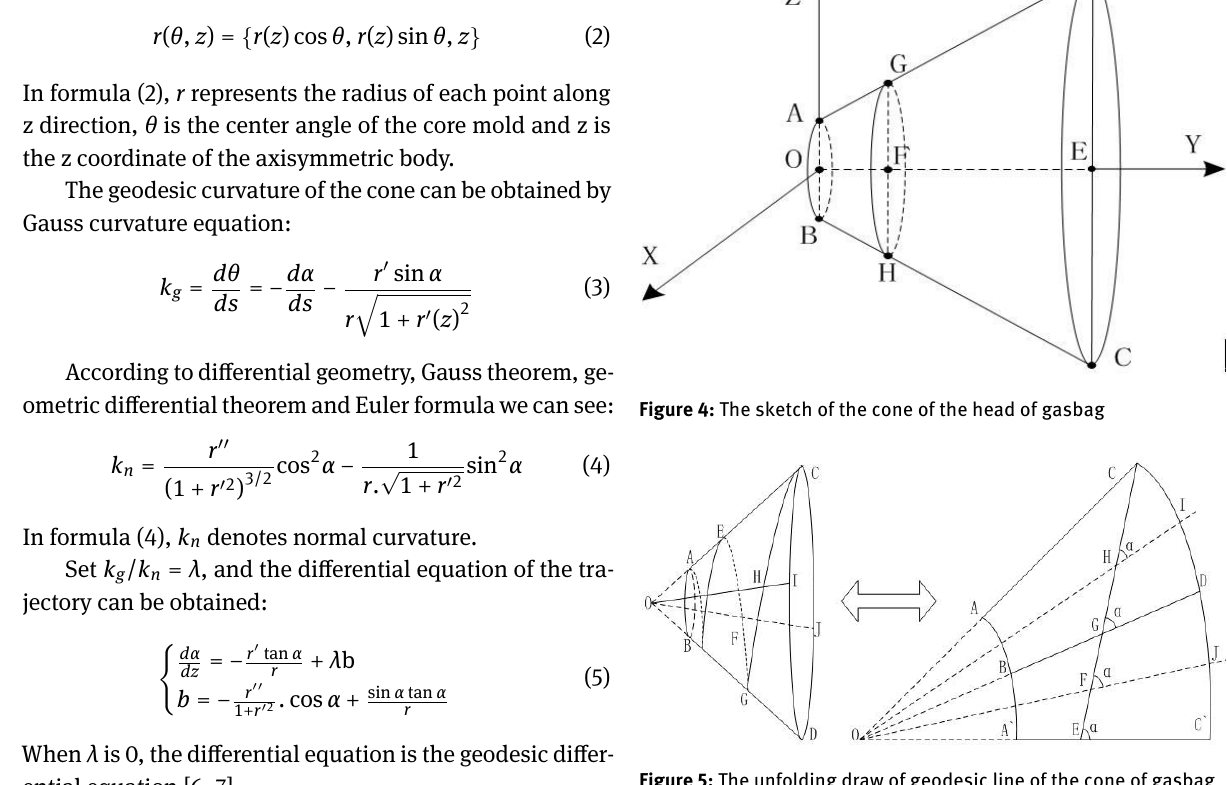
Figure 5: The unfolding draw of geodesic line of the cone of